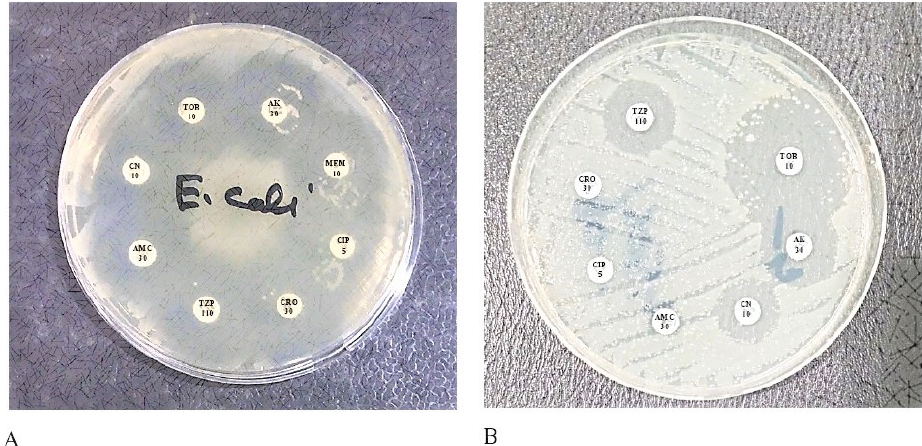
Figure 1. The transformation between ESBL and Non-ESBL bacteria. Ceftriaxone (CRO) antibiotic is a third-generation cephalosporin that is reactive to non-ESBL strains but Non-reactive to ESBL strains; ( A ) is a non-ESBL strain so susceptible to CRO; ( B ) is an ESBL strain and CRO